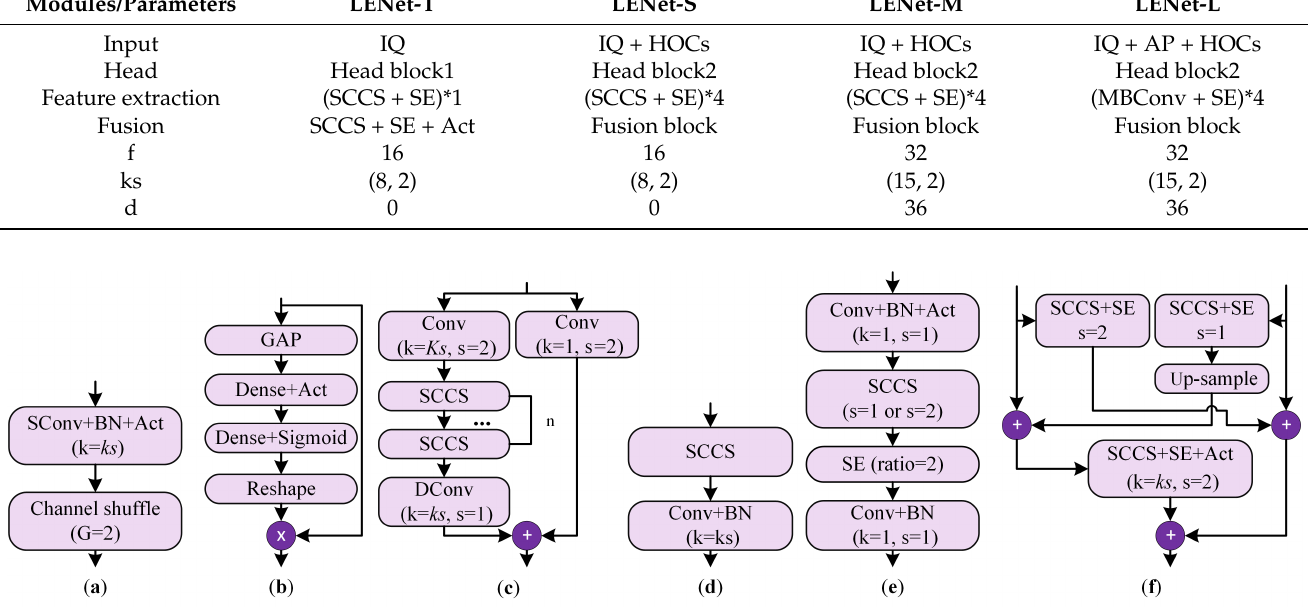
Figure 3. Core modules of proposed LENet models: ( a ) SCCS module, ( b ) SE module, ( c ) Head block1, ( d ) Head block2, ( e ) MBConv module, and ( f ) fusion